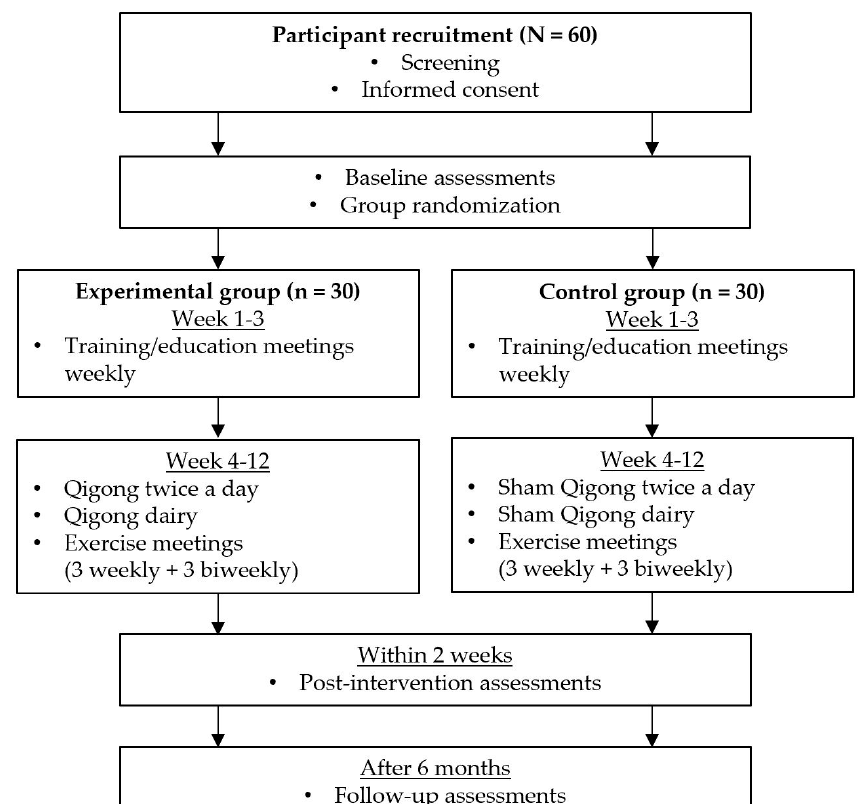
Figure 1. Study flow chart. A screening will be conducted using the screening tool developed